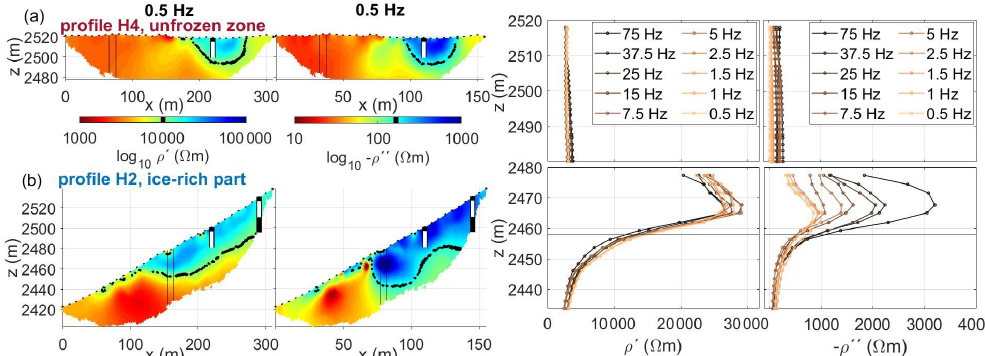
Figure 7. Extracted complex resistivity values (real and imaginary components) in a virtual borehole in (a) an unfrozen zone (top, profile H4) and (b) an ice-rich part (bottom, profile V2) of the study area indicating the different spectral responses for the two positions. Extracted values correspond to mean values over a pixel width of 10m along the vertical black lines in the